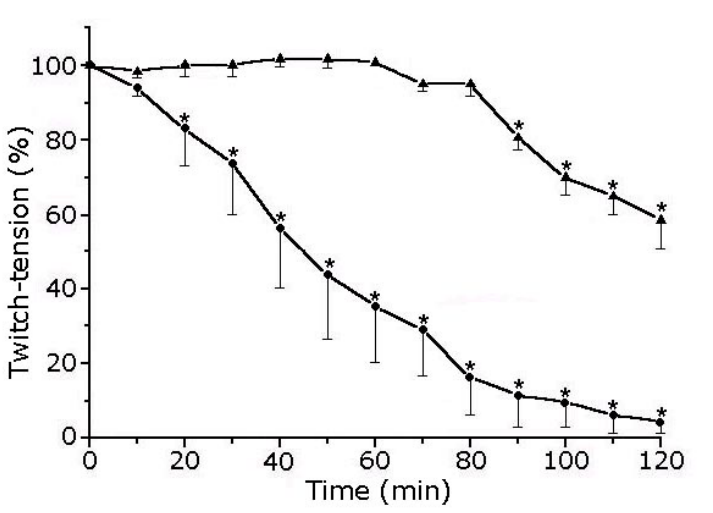
Figure 2. The effect of replacing 1.8 mM Ca 2+ for 4.0 mM Sr 2+ in the blocking activity of B. n. pauloensis venom (50 µ g/ml) as measured by the development of twitch- tension in indirectly stimulated mouse diaphragm. Preparations incubated with normal Tyrode solution plus venom ( (cid:122) ) and Ca 2+ -free Tyrode solution plus 4.0 mM Sr 2+ and venom ( ▲ ). Each point represents mean ± S.E.M. of 3-6 experiments. All points indicated by an asterisk differed significantly from control preparations ( p < 0.05).